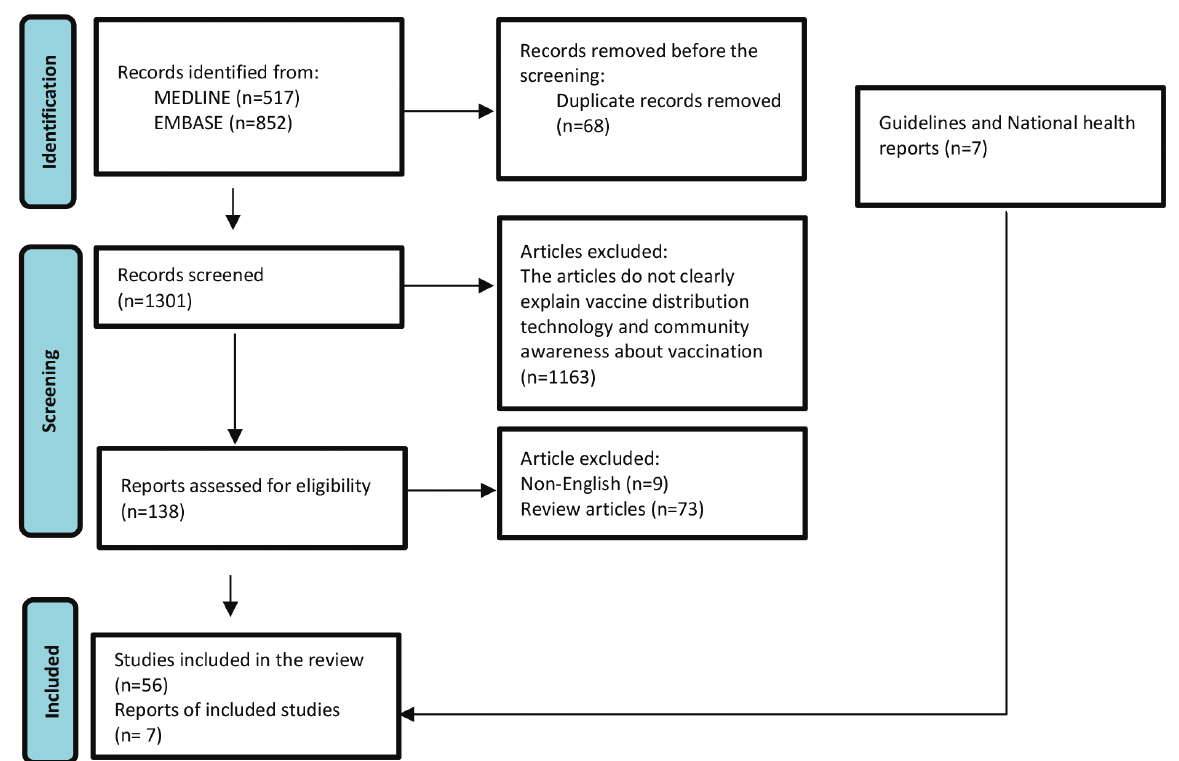
Figure 1. PRISMA Flow Diagram of Literature